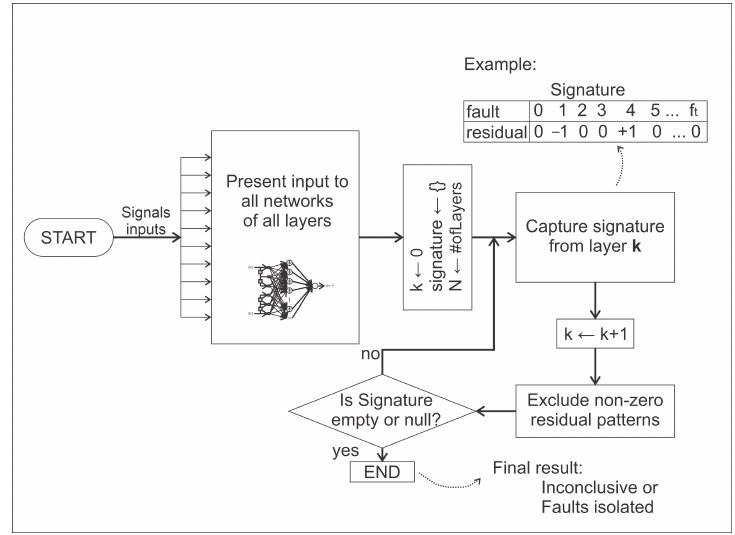
Figure 16. Iterative process of obtaining signatures and fault isolation.